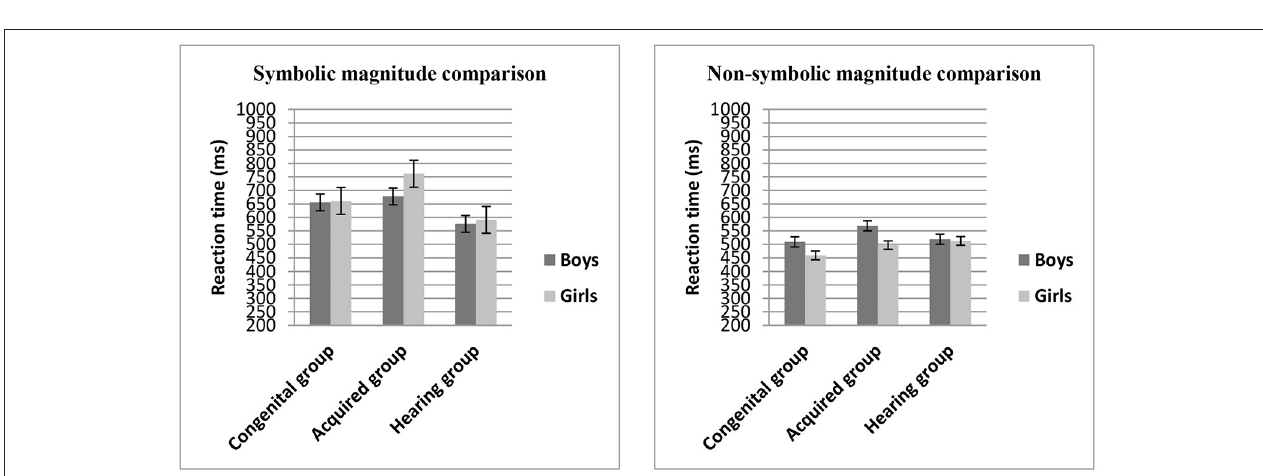
FIGURE 2 | Mean reaction time (ms) on the numerical magnitude comparison task (symbolic and non-symbolic) across groups.